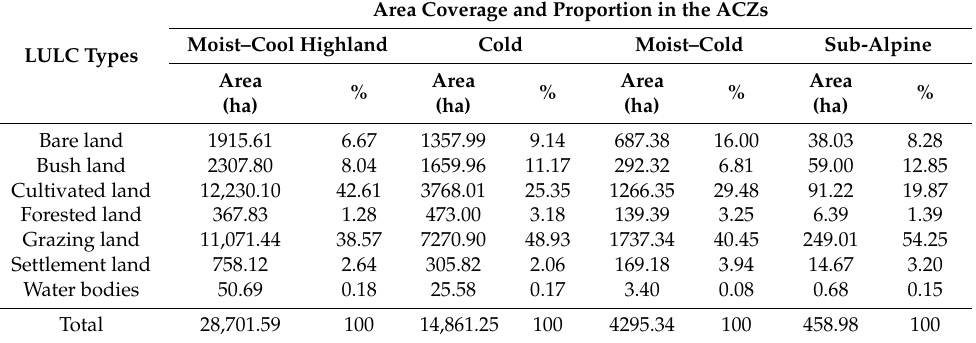
Figure 6. The spatial distribution of land-use land cover in the Jema watershed. Table 8. Area coverage (and proportion) of the classified LULC types among the ACZs of the Jema